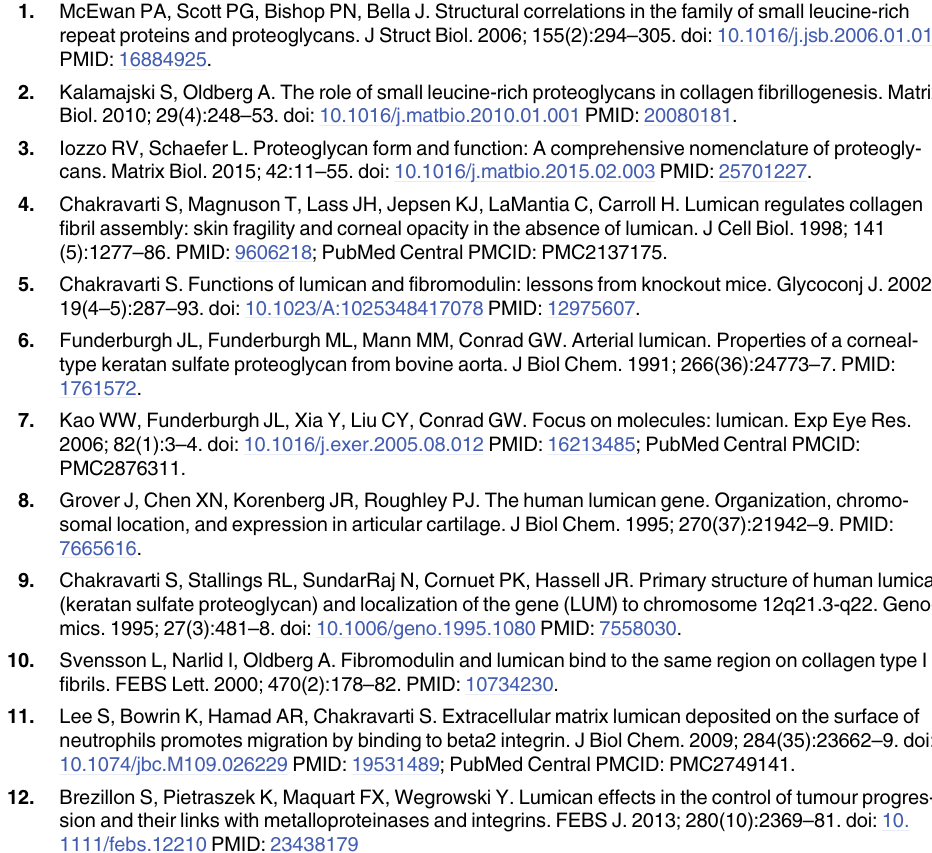
S1 Table. List of primers used for quantitative real time PCR reaction. SNAI1 : snail